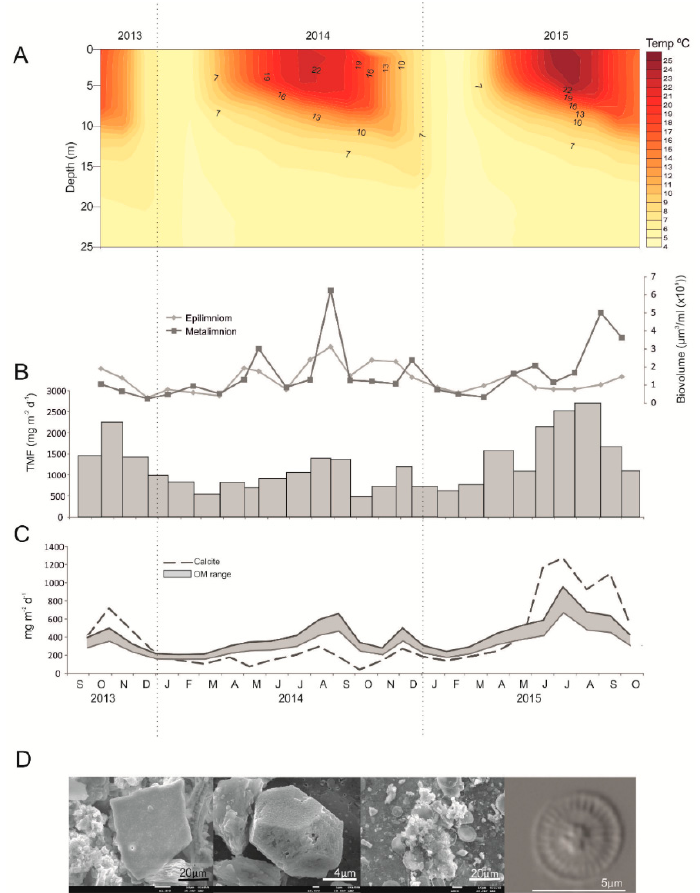
Figure 2. Summary of monthly water column and sediment trap monitoring. ( A ) Water column temperature at 1 m resolution. ( B ) Total mass fluxes (TMF) of monthly sediment traps compared with the phytoplankton biovolume of epi- and metalimnion. ( C ) Calcite fluxes versus organic matter (OM) fluxes of sediment trap material. ( D ) Well-formed blocky and rhombohedral calcite crystals, calcite crystals and diatom frustules and one of the small centric diatoms found in sediment trap material. Redrawn and modified from [18].